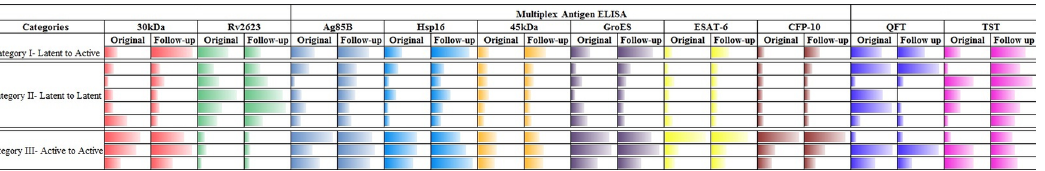
Fig 6. Evaluation of TB biomarkers in original and follow-up samples of the population under study. Chart shows a comparison between the levels of TB biomarkers (30 kDa antigen, ADA; Adenosine deaminase, Mycobacterial Dormancy Regulon Protein Rv2623, Multiplex antigens; Ag85B; M . tb Ag85B secretory protein, Hsp-16; 16 kDa heat-shock protein, 45kDa antigen, GroES; M . tb 10kDa chaperonin, ESAT-6; 6 kDa early secretory antigenic target and CFP-10; 10 kDa culture filtrate protein, QFT; QunatiFERON-TB Gold test and TST; Tuberculin Skin Test) in original and follow-up cases of Melghat categorized into three groups; Latent to Active TB group (n = 1), Latent to Latent TB Group (n = 5) and Active to Active TB group (n =